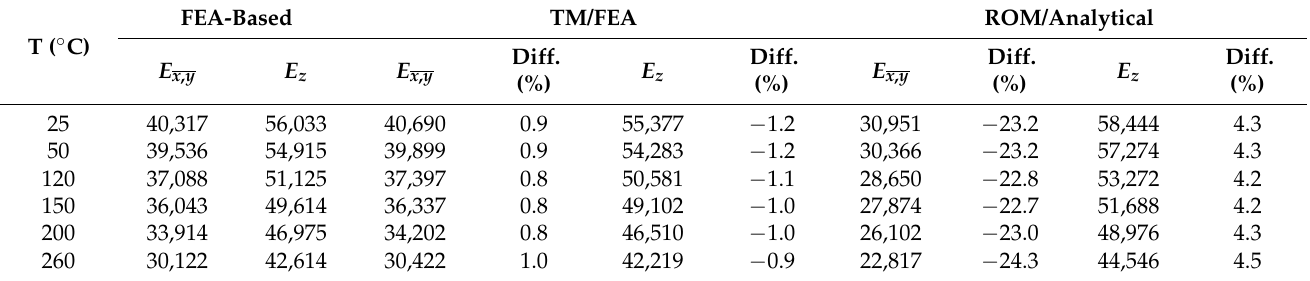
Table 2. Comparison of calculated effective elastic moduli (MPa) using three different approaches.